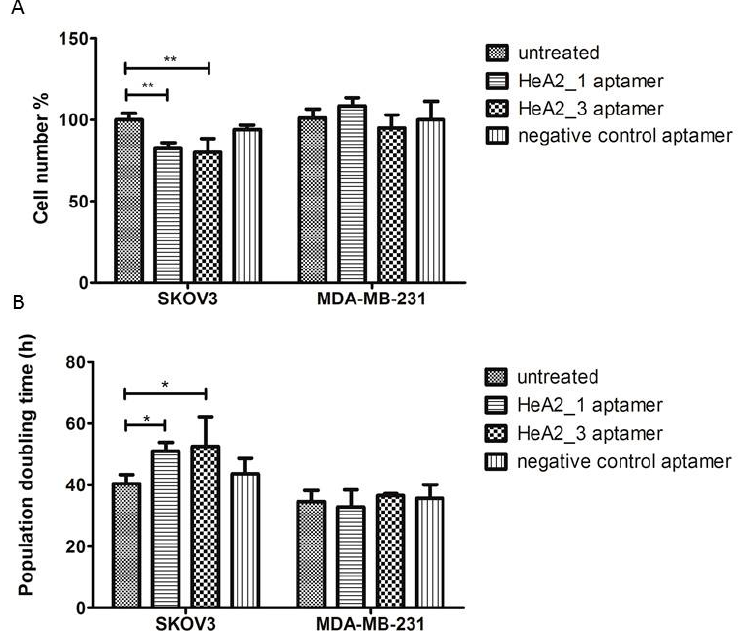
Figure 9. Targeted inhibition of cell growth by selected aptamers. ( A ) Bar graphs represent % cell number after 5 days of daily treatment with or without 0.1 µM aptamer. n ≥ 3 biological replicates, error bars represent SD, significance of differences between treated vs. untreated cells was tested using the 2-way ANOVA test with ** p < 0.01 ( B ) Bar graphs represent overall population doubling time (h) after daily treatment with or without 0.1 µM aptamer. n ≥ 3 biological replicates, error bars represent SD, significance of differences between treated vs. untreated cells was tested using the 2-way ANOVA test with * p < 0.05.